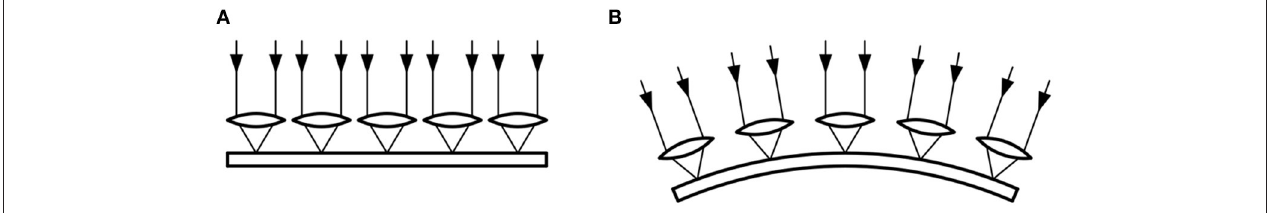
FIGURE 14 | Another possibility for a zooming feature is a flexible image sensor, depicted at the bottom; it can be equipped with tiny lenses, each focusing on a single pixel on the image sensor. (A) Flat sensor. (B) When spherically bent (convex or concave), the angle of light entering can be changed, which corresponds to angle β .